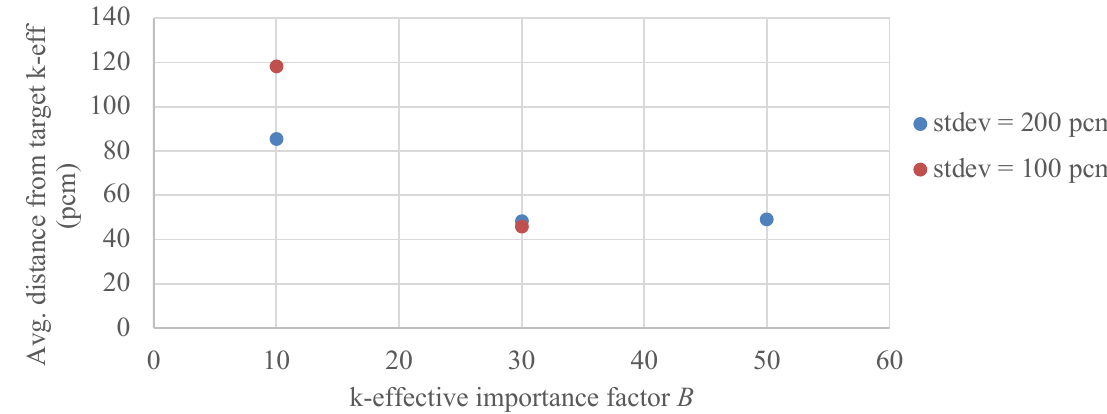
Figure 2. Average distance from target k-effective at BOC